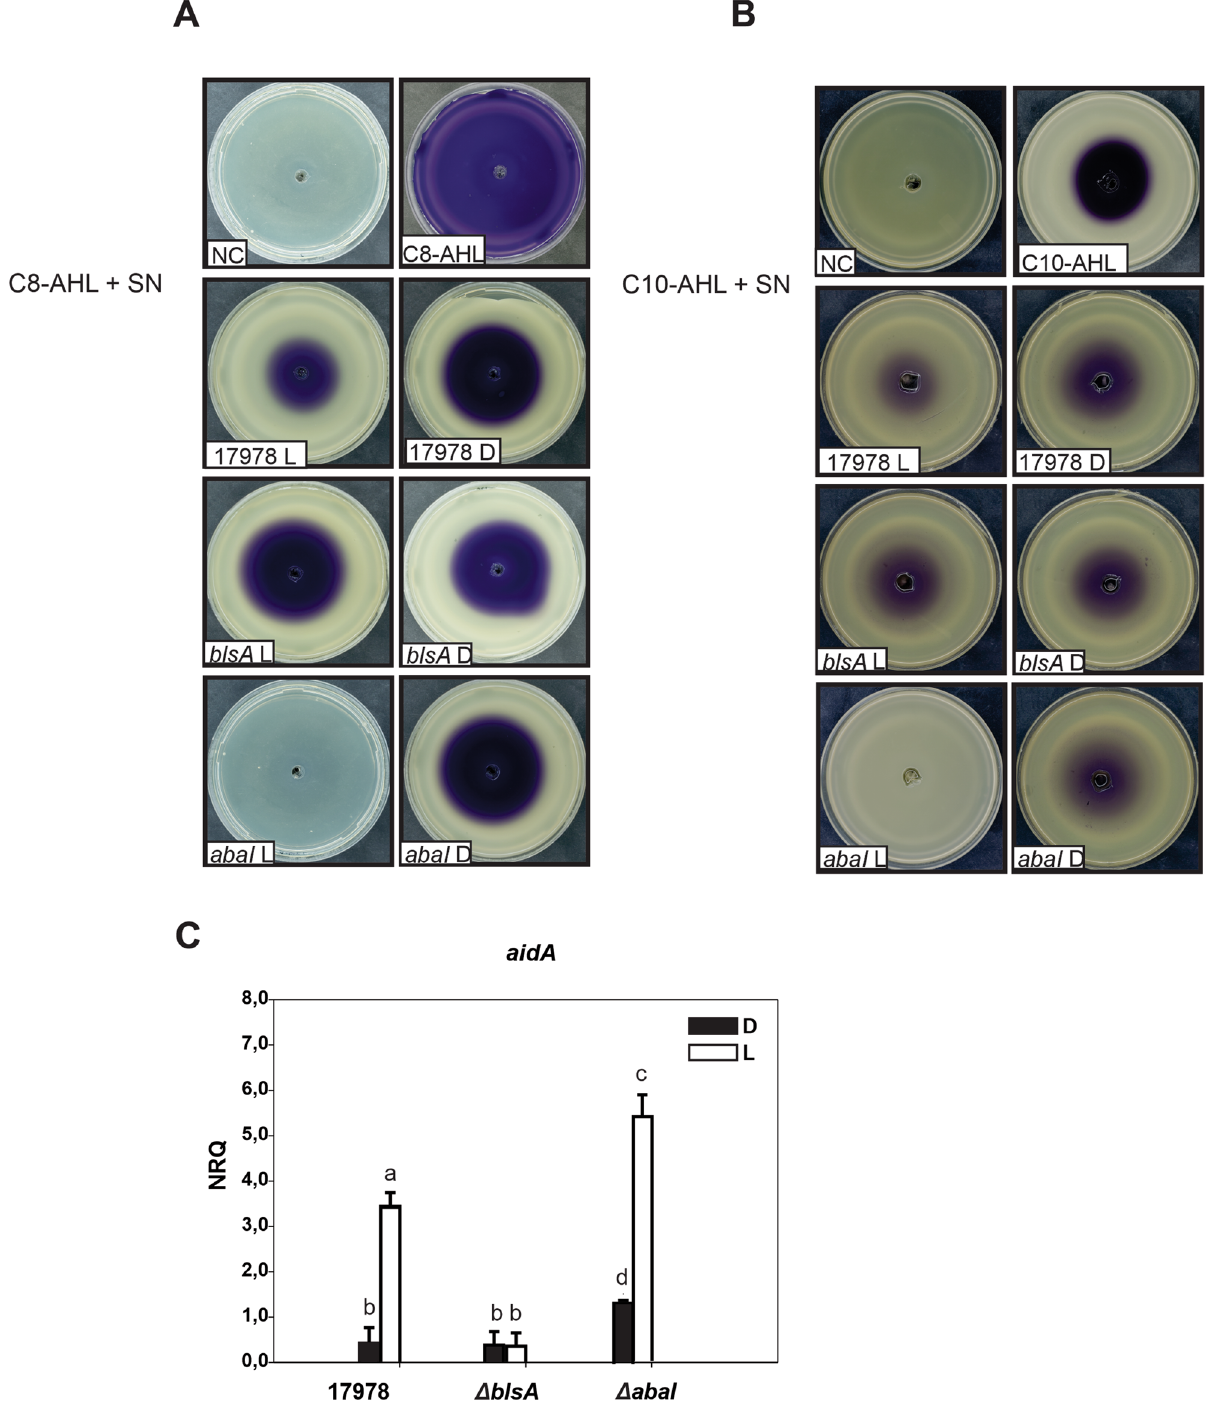
Figure 2. Light modulates quorum quenching activity and aidA expression at environmental temperatures in A. baumannii . ( A , B ) Quorum quenching assays were performed by incubating the post-sonicated supernatants recovered from motility plates of the indicated strains incubated under blue light or in the dark at 23 °C and normalized to OD 660 = 1.5, with 2 µg of commercial standard for 6 h at 37 °C. After incubation, the mixture was then loaded in a central well of biosensor-inoculated LB plates. The biosensors used are the short-chain AHL biosensor C. subtsugae CV026 ( A) as well as the long-chain AHL biosensor C. violaceum VIR07 ( B ). Negative control (NC) was performed by inoculating PBS 1X in the central well of the plates. The positive controls (standards labeled C8-AHL or C10-AHL) were performed by adding 2 µg of each commercial standard. The extent of inhibition of violacein production compared to the control provides an indication of lactonase activity. Plates were inspected and photographed after incubation in darkness (D) at 30 °C for 24 h. Shown are representative results from three independent experiments. ( C ) Estimation by qRT-PCR of the expression levels of the gene coding for a lactonase, aidA, in cells recovered from motility plates inoculated with ATCC 17978 wild-type, ∆blsA and ∆abaI incubated at 23 °C under blue light (L) or in the dark (D). Shown are the mean and standard deviation of normalized relative quantities (NRQ). Significant differences determined by ANOVA followed by Tukey’s multiple comparison test ( p < 0.05) are indicated by different letters. Representative results of three independent experiments are